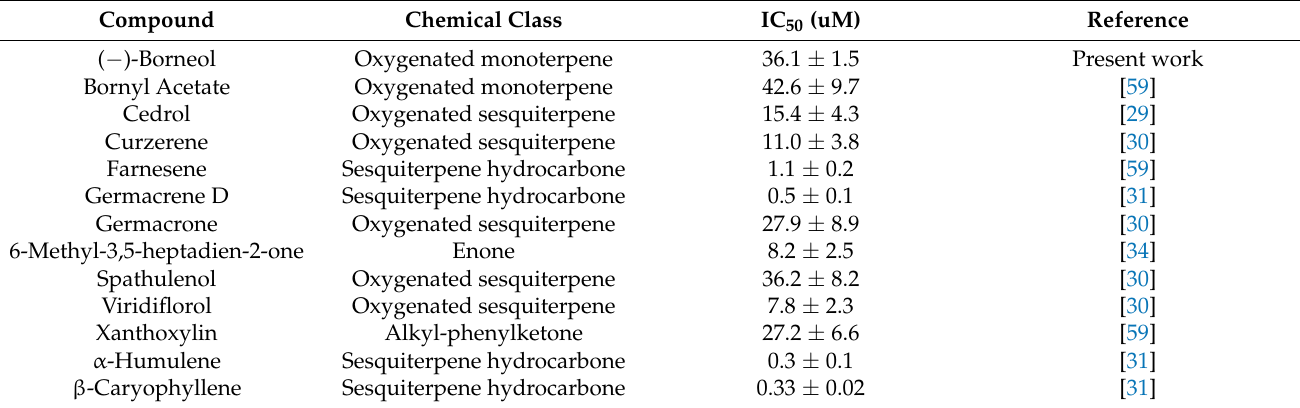
Table 5. Inhibitory effect of pure component compounds of essential oils on [Ca 2+ ] i in human